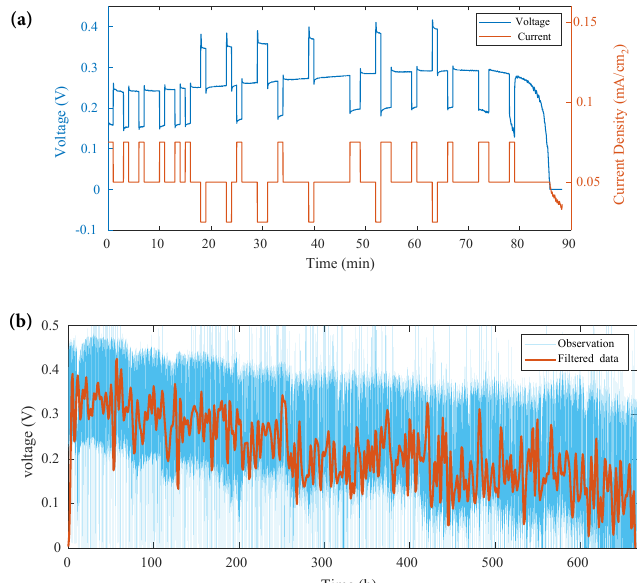
Figure 2. µ DMFC output voltage: ( a ) A discharging cycle with loading current; ( b ) collected output voltage and filtered data in aging